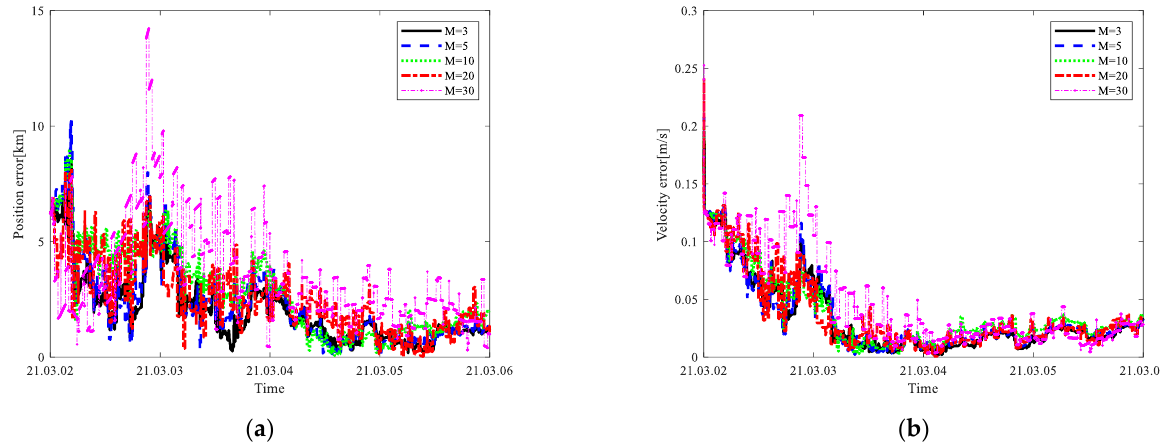
Figure 6. Navigation results of the parameter-independent event-triggered mechanism only consid- ering innovation. ( a ) Position error. ( b ) Velocity error. Table 6. Navigation results of the parameter-independent event-triggered mechanism only consid- ering innovation, with different M .